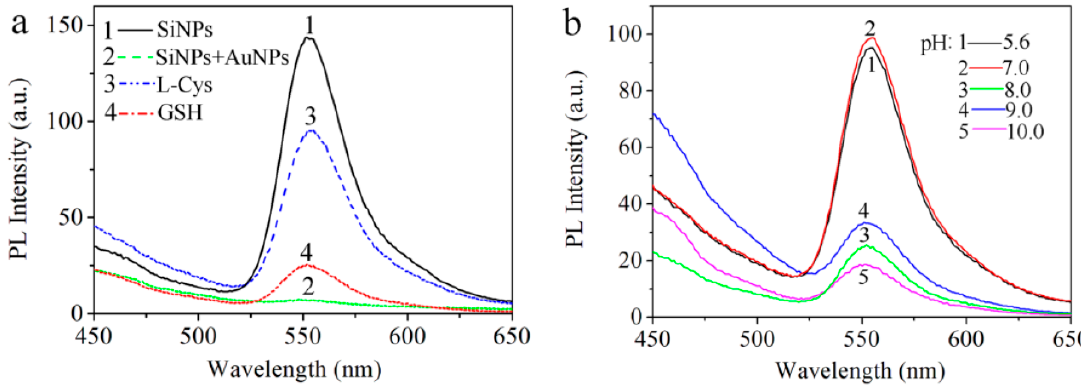
Figure 5. ( a ) Fluorescence emission spectra of SiNPs-AuNPs in ethanol (pH: 5.6) in the presence of 5 mM L-Cys and GSH. (1) SiNPs-ethanol solution, (2) SiNPs-AuNPs in ethanol, (3) SiNPs-AuNPs in ethanol in the presence of 5 mM L-Cys and (4) SiNPs-AuNPs in ethanol in the presence of 5 mM GSH; ( b ) The fluorescence intensity of SiNPs-AuNPs in ethanol in the presence of L-Cys under different pH ( λ ex: 350 nm, λ em: 550 nm).